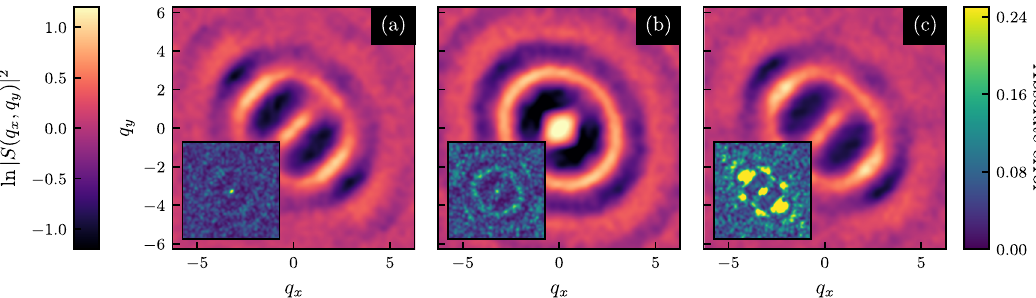
Fig. 6 Structure factors of force chains predicted by the graph neural network. a Structure factor of force chains predicted by a GNN at ϕ = 0.86; the GNN was conditioned on the packing fraction ϕ , and trained on data for ϕ = {0.86, 0.88, 0.90}. b Same as in (a), but now predictions are made at ϕ = 1.0, for which the GNN was not trained. c Structure factor of force chains predicted at γ = 0.16 by a GNN conditioned on γ and trained on γ = {0.02, 0.03, 0.04}. Inset (in all three cases) shows an absolute error of the structure factor w.r.t. the structure factor of the exact force chains; a distinct pattern can be observed in the inset of ( b ) and (